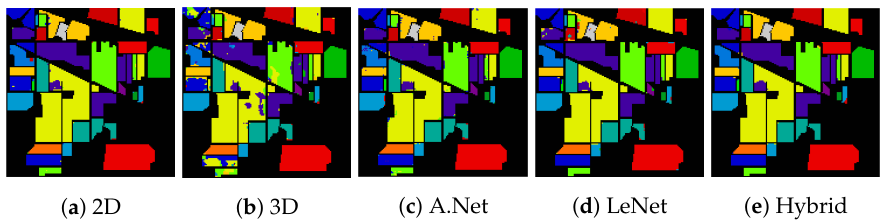
Figure 2. Indian Pines: Classification accuracy: ( a ) 2D-CNN = 98.94%; ( b ) 3D CNN = 91.57%; ( c ) AlexNet = 97.65%; ( d ) LeNet = 98.14%; and ( e ) Hybrid =